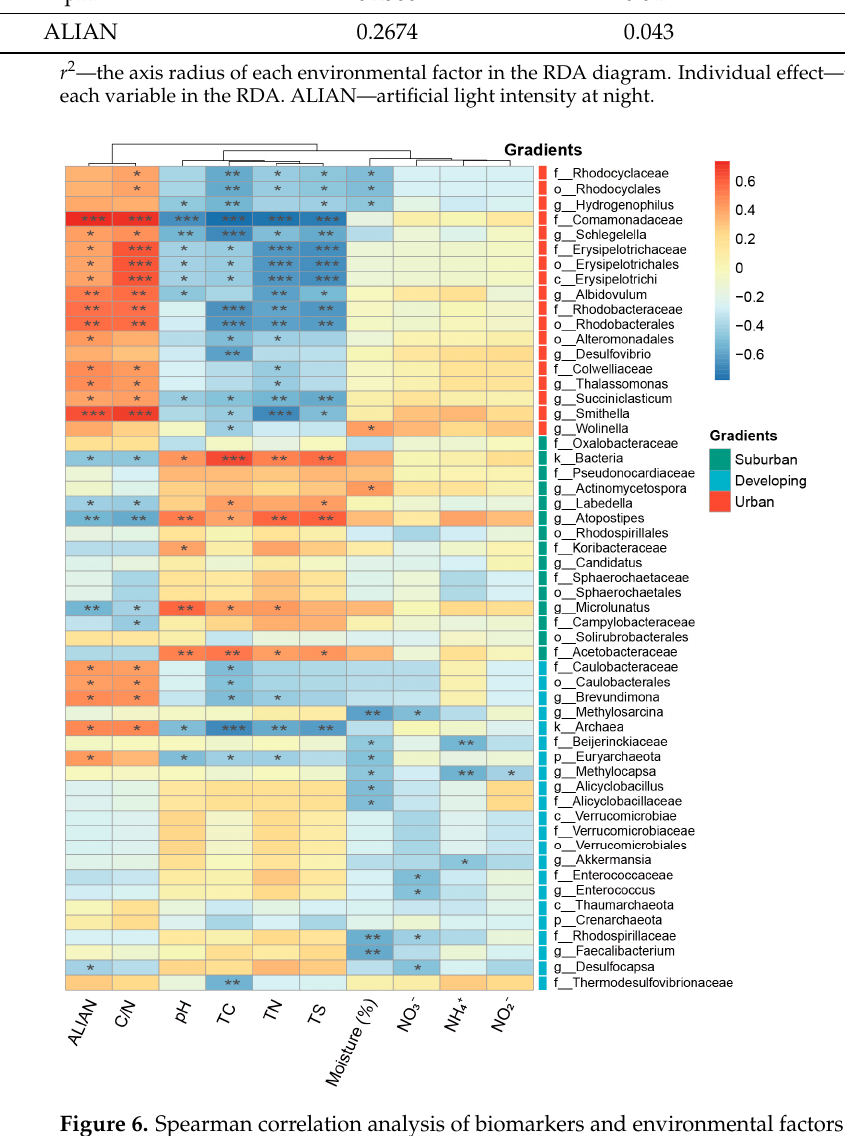
Figure 6. Spearman correlation analysis of biomarkers and environmental factors. Suburban, developing, and urban stand for the corresponding biomarkers of different urbanization levels. An asterisk denotes a significant statistical difference between treatments (*, p < 0.05; **, p < 0.01; ***, p < 0.001), and the blank indicates that the statistical difference is not significant. ALIAN—artificial light intensity at night. Moisture (%)—water content (%) of camphor leaves along the urbanization gradient.